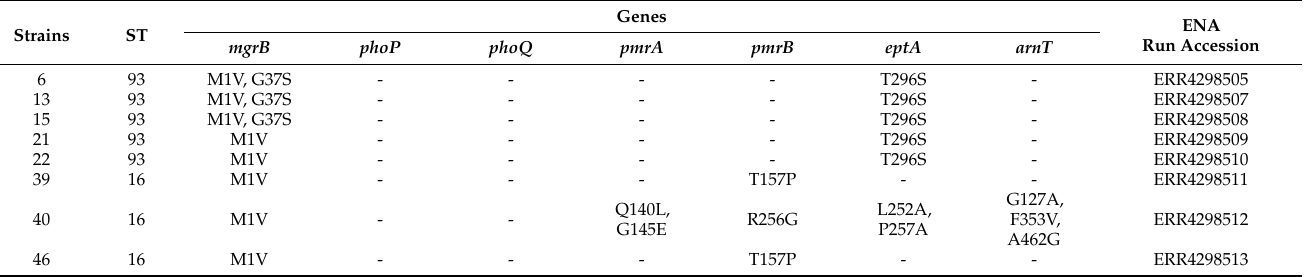
Table A3. Evaluation of deleterious mutations related to polymyxin resistant in K. aerogenes